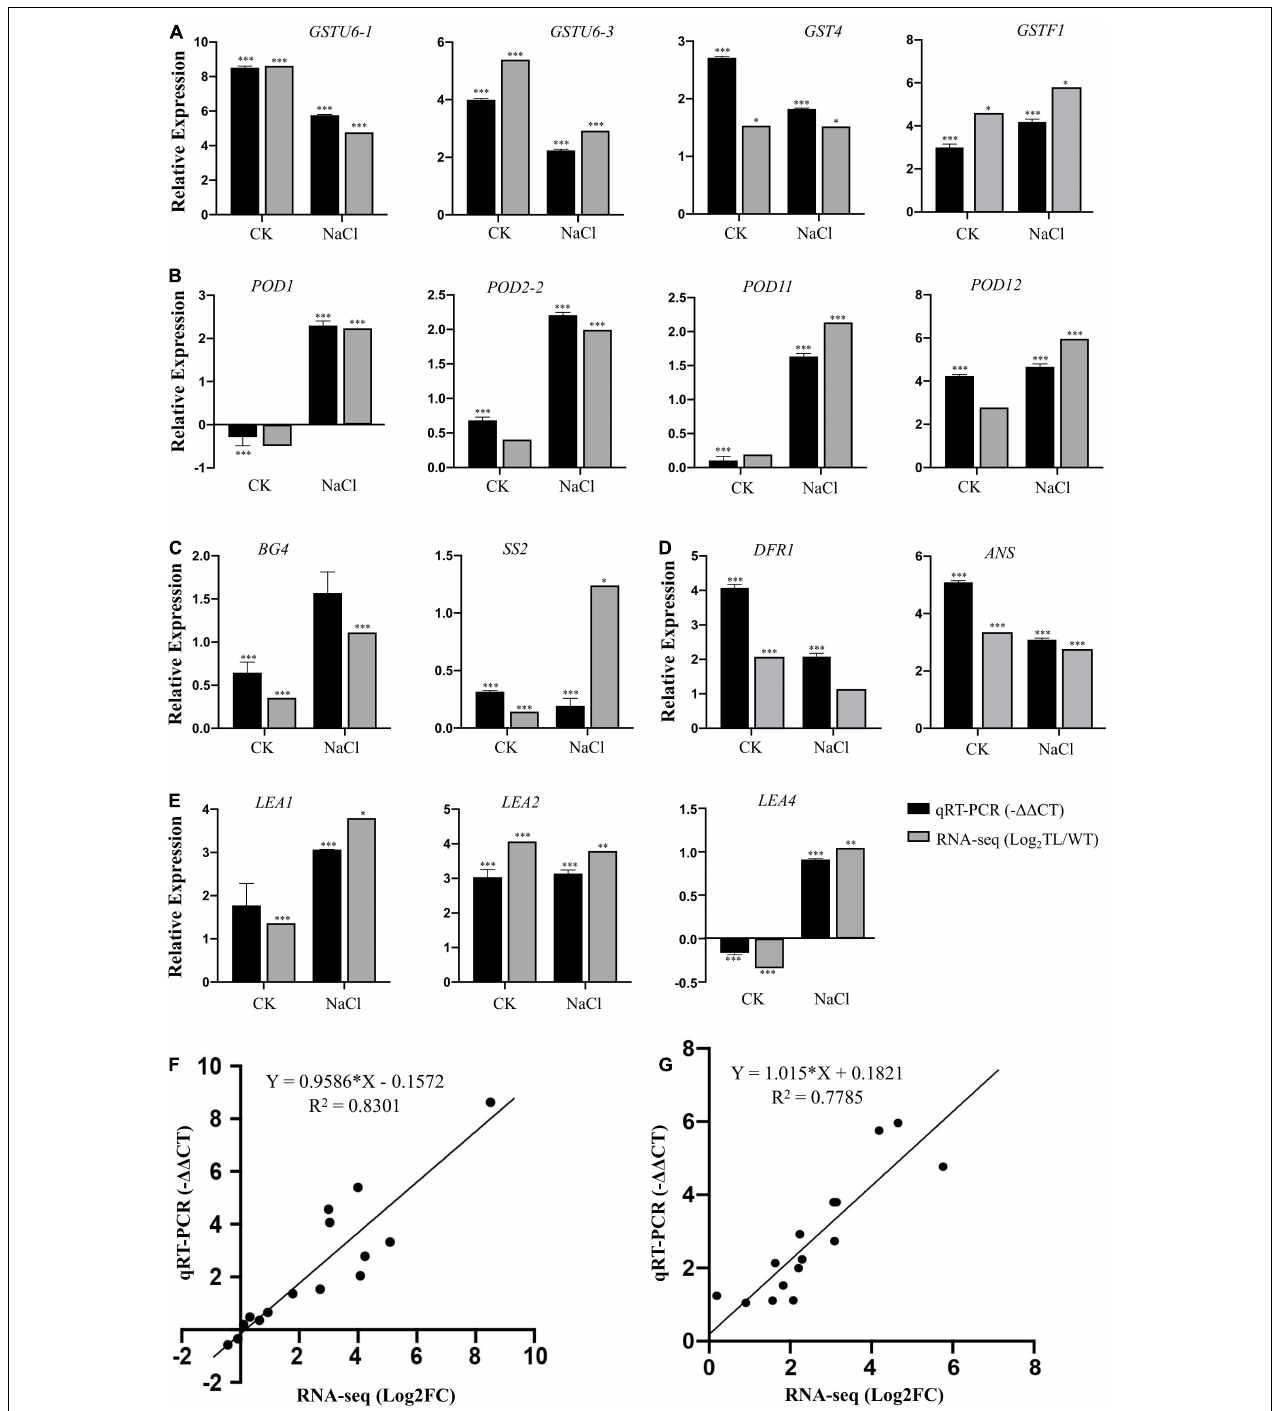
FIGURE 8 | Validation of RNA-seq result using qRT-PCR. Expression verification of 15 genes including (A) GST genes, (B) POD genes, (C) Sucrose and glucans metabolism related genes, (D) Anthocyanin biosynthesis related genes, (E) LEA protein encoding genes, in RNA-seq by qRT-PCR. Black bars indicate − (cid:49)(cid:49) CT of DEGs in qRT-PCR, and gray bars show log 2 FC (TL/WT) of DEGs in RNA-seq. The Tatub4 ( tubulin beta-4 , TraesCS5A02G416400 ) was used as an internal control gene. Each set of data was obtained from three biological replications, and the vertical bar represents the standard error of 3 biological replications. ∗ p ≤ 0.05, ∗∗ p ≤ 0.01, and ∗∗∗ p ≤ 0.001 indicate the significance of gene expression in transgenic wheat plants compared with the WT under salt stress. Correlation analysis of results between RNA-seq [X-axis:log 2 FC (TL/WT)] and qRT-PCR (Y-axis: – (cid:49)(cid:49) CT) in the normal condition (F) and NaCl treatment condition (G)